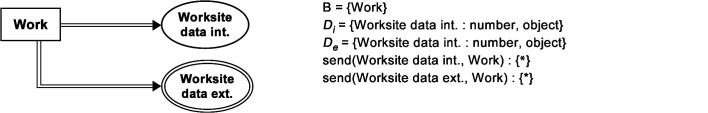
 BDRML representation of the Information Exchange Anywhere design pattern.